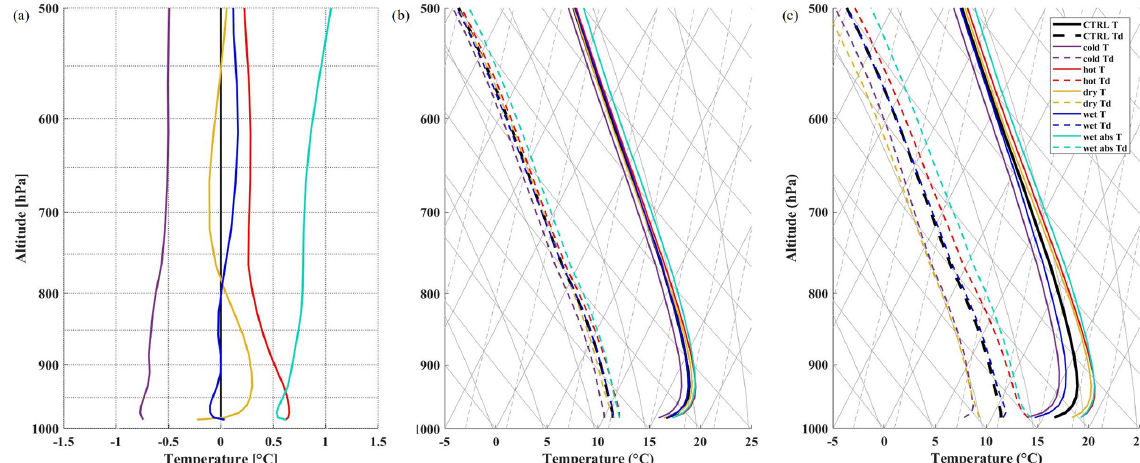
Figure 9. (a) Divergence temperature ( T ) factors derived from differences of the domain average temperature profiles of the corresponding summers to the 30-year mean (Table 2) which were used to modify daily model output, (b) domain average of T and T d profiles for the divergence T factors, and (c) their additional modifications with the core T factor. Purple: cold, red: hot, yellow: dry, blue: wet, turquoise: wet abs; solid lines represent temperature and dashed lines represent dew-point temperature.